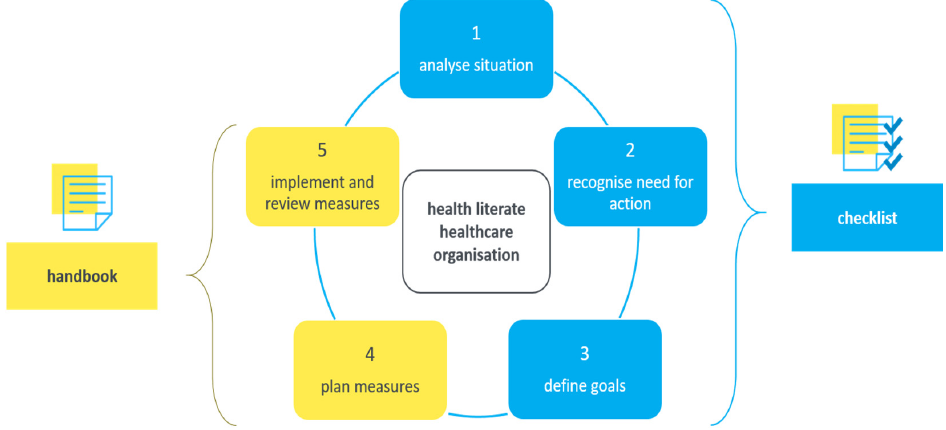
Figure 1. Stepwise organizational improvement process.